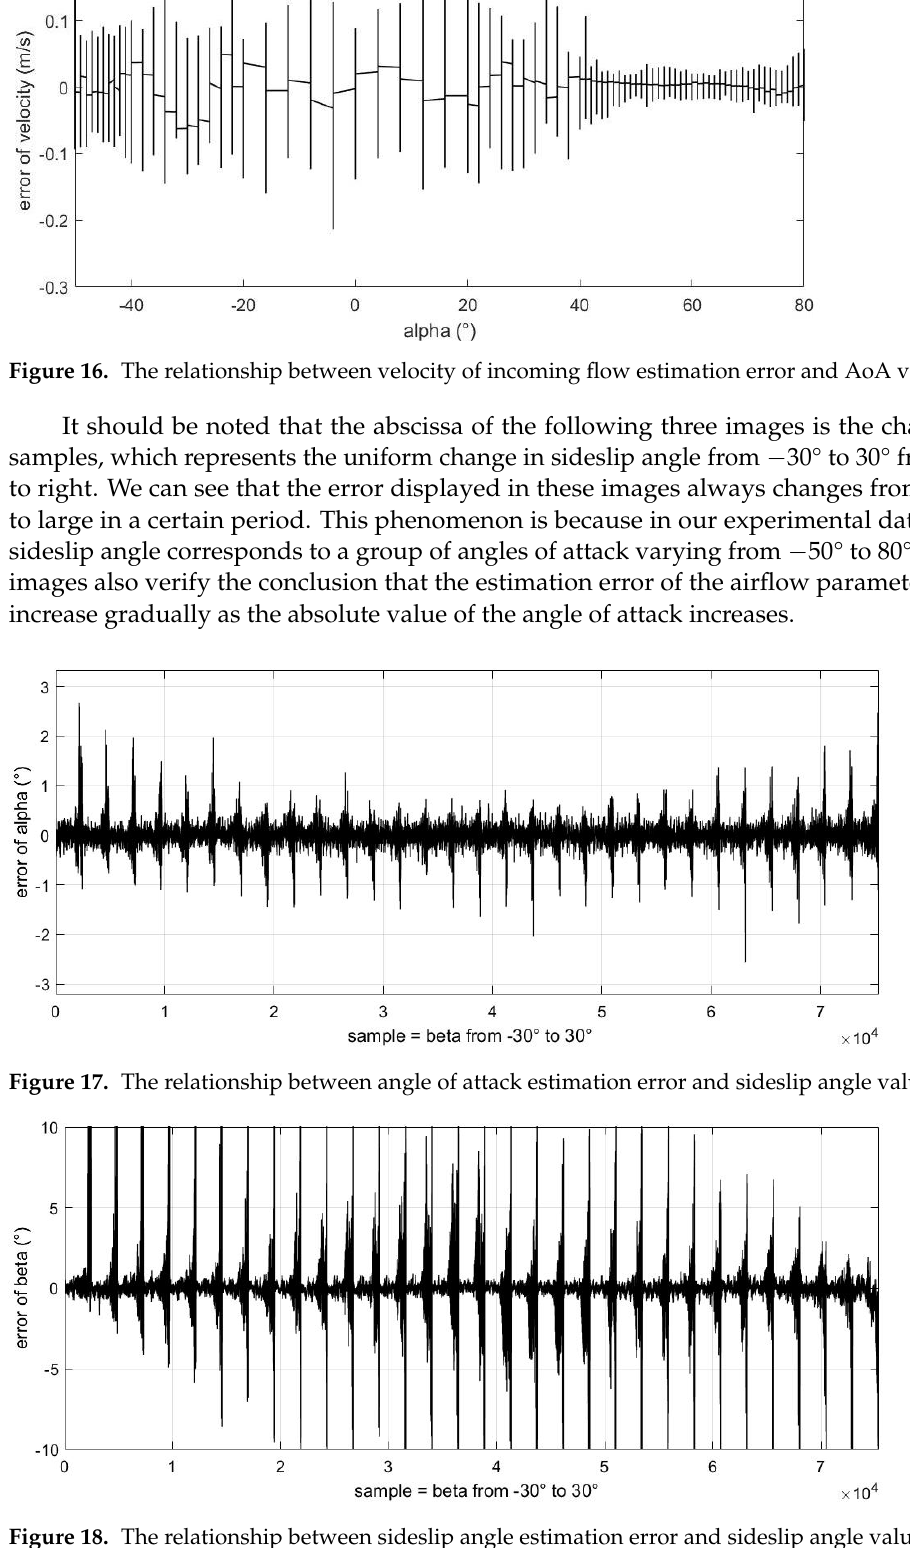
Figure 18. The relationship between sideslip angle estimation error and sideslip angle